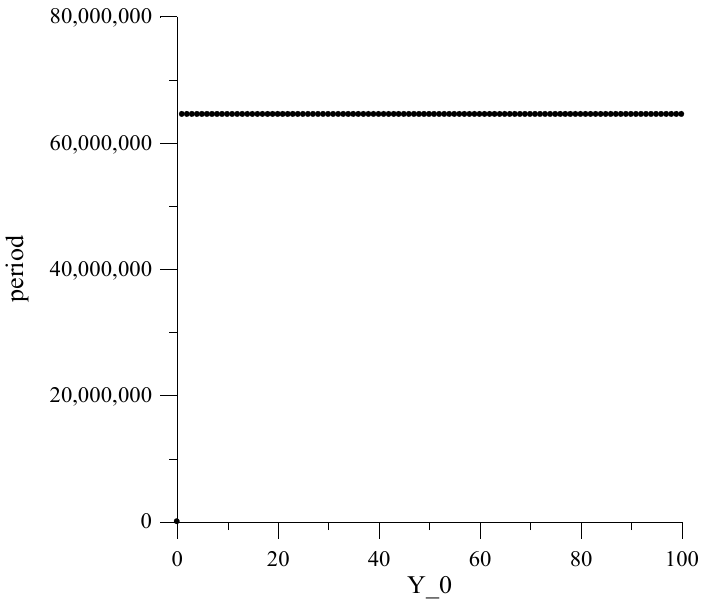
= = and 0 a . Figure 5. Dependencies of repetition periods for X _0, h = 3 and a = 0.